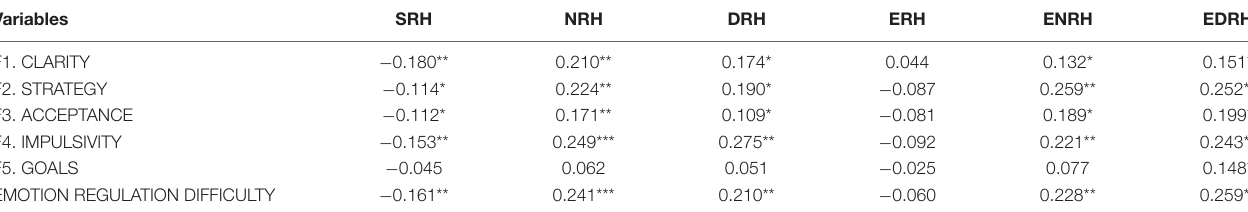
TABLE 5 | Bivariate correlations between self vs. external regulation (SR-ER) and difficulties inherent to executive functions (EFs).